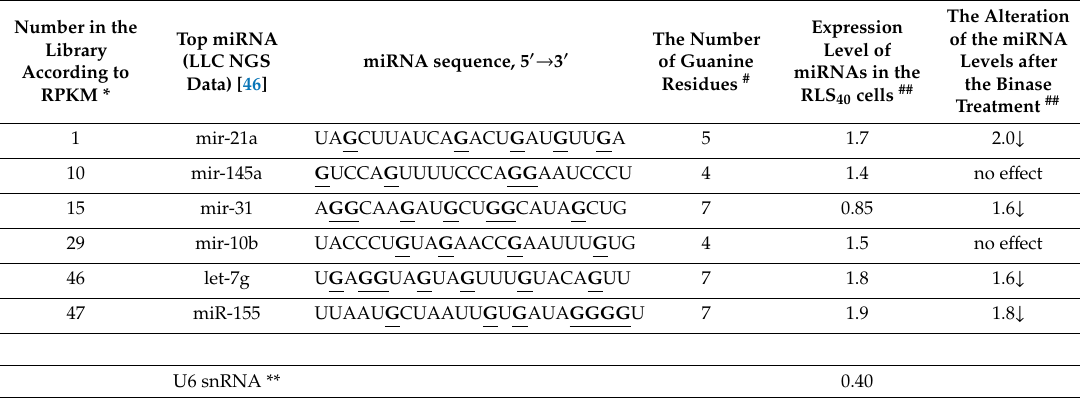
Table 1. The levels of miRNAs in RLS 40 cells and altered levels after the cell treatment with binase in